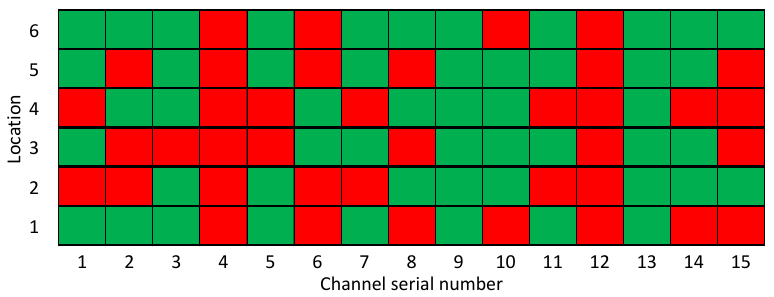
Figure 8. Channel occupied bit map illustration for m -tolerate coexistence